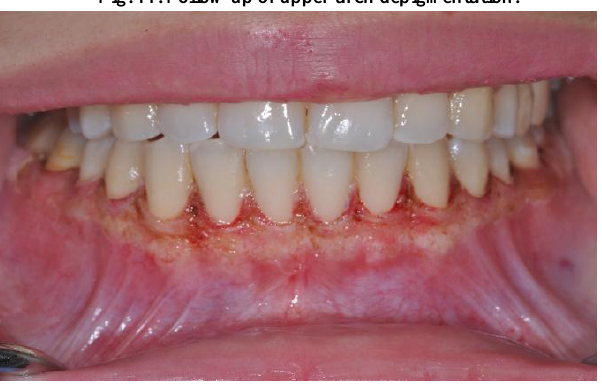
Fig. 11. Follow-up of upper arch depigmentation.